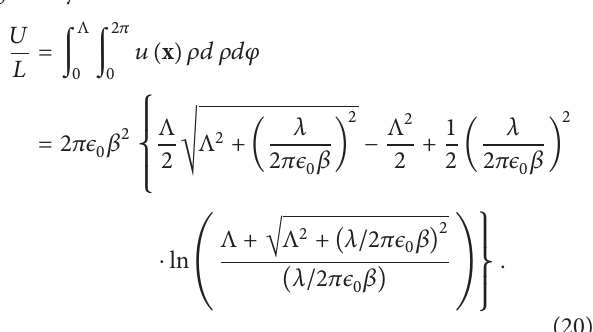
Figure 2: The Gaussian surface for an infinitely long cylinder of radius 𝑅 . (a) Inside the cylinder (𝜌 < 𝑅) . (b) Outside the cylinder (𝜌 > 𝑅) . Using (19), the stored electrostatic energy per unit length for an infinite charged line in the radial interval 0 ≤ 𝜌 ≤ Λ is given